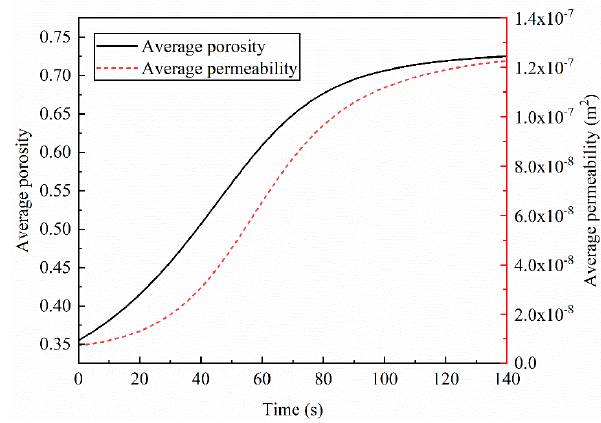
Figure 11. Average porosity curve and average permeability curve.